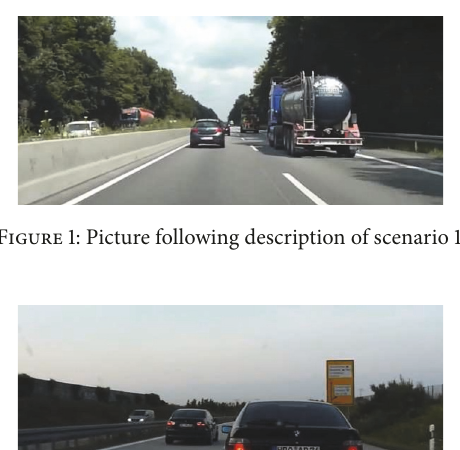
participants of which 77.4% (N = 82) were male. This group had a mean age of 43.77 years (SD = 10.14). The youngest participant was 24 years old and the oldest